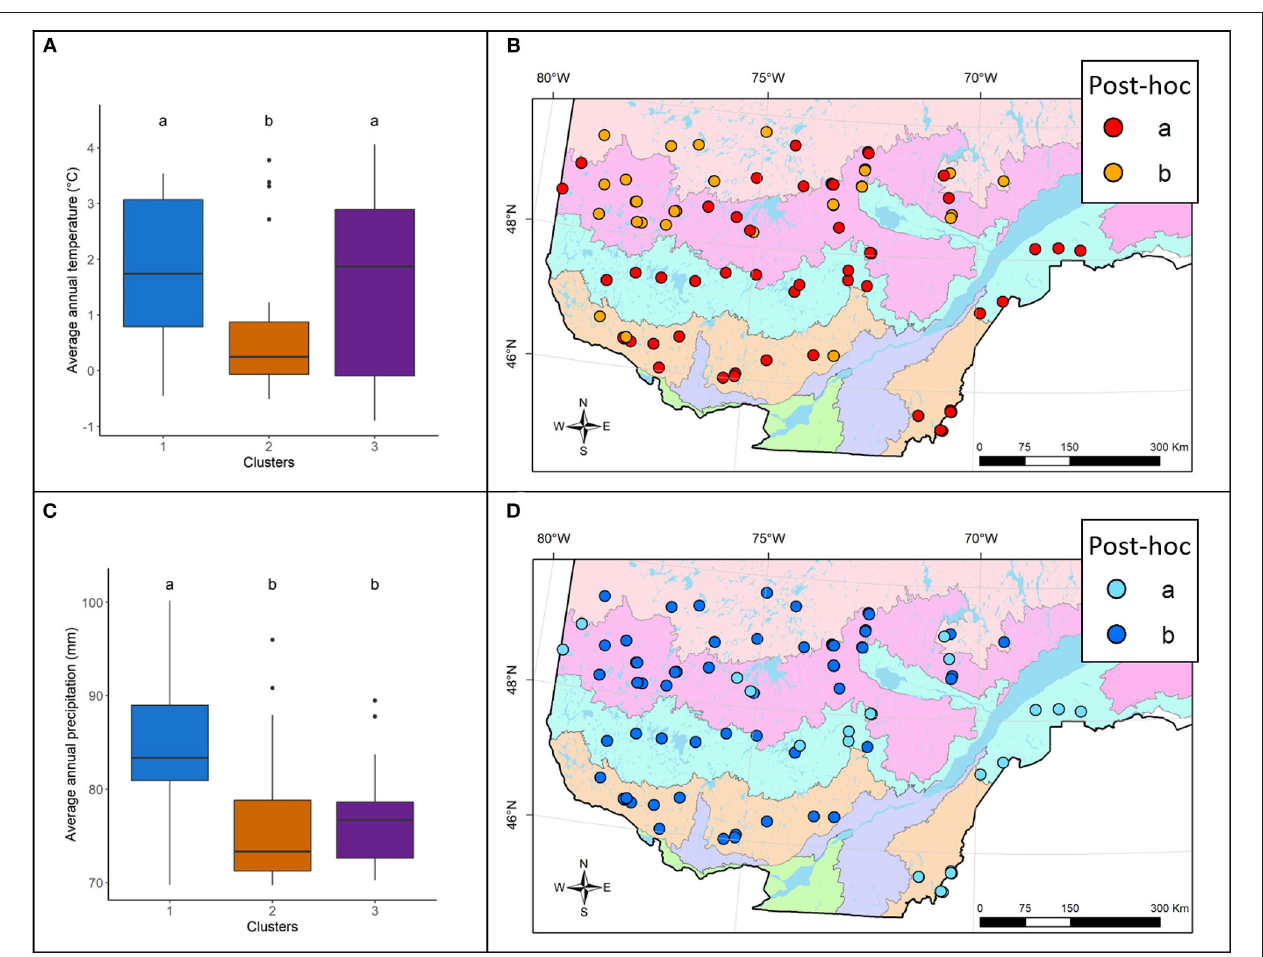
FIGURE 4 | (A) Boxplot representing the mean annual temperature ( ◦ C) for each cluster presented with the post-hoc test results (a > b) and (B) maps showing these post-hoc results. (C) Boxplot representing the mean annual precipitation (mm) for each cluster presented with the post-hoc test results (a > b) and (D) maps showing these post hoc results. For the background map legend see Figure 1